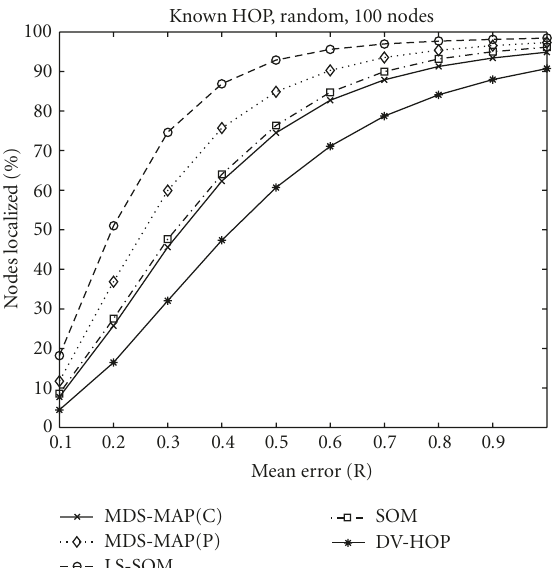
Figure 11: Distribution of nodes localized ( G = 4 to 15).